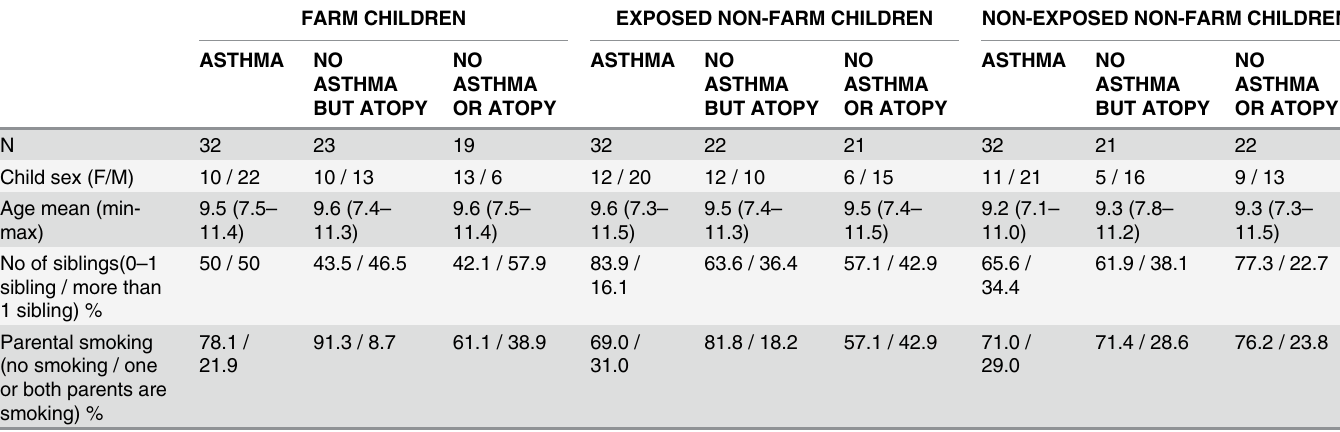
Table 1. General characteristics of the study population (n =